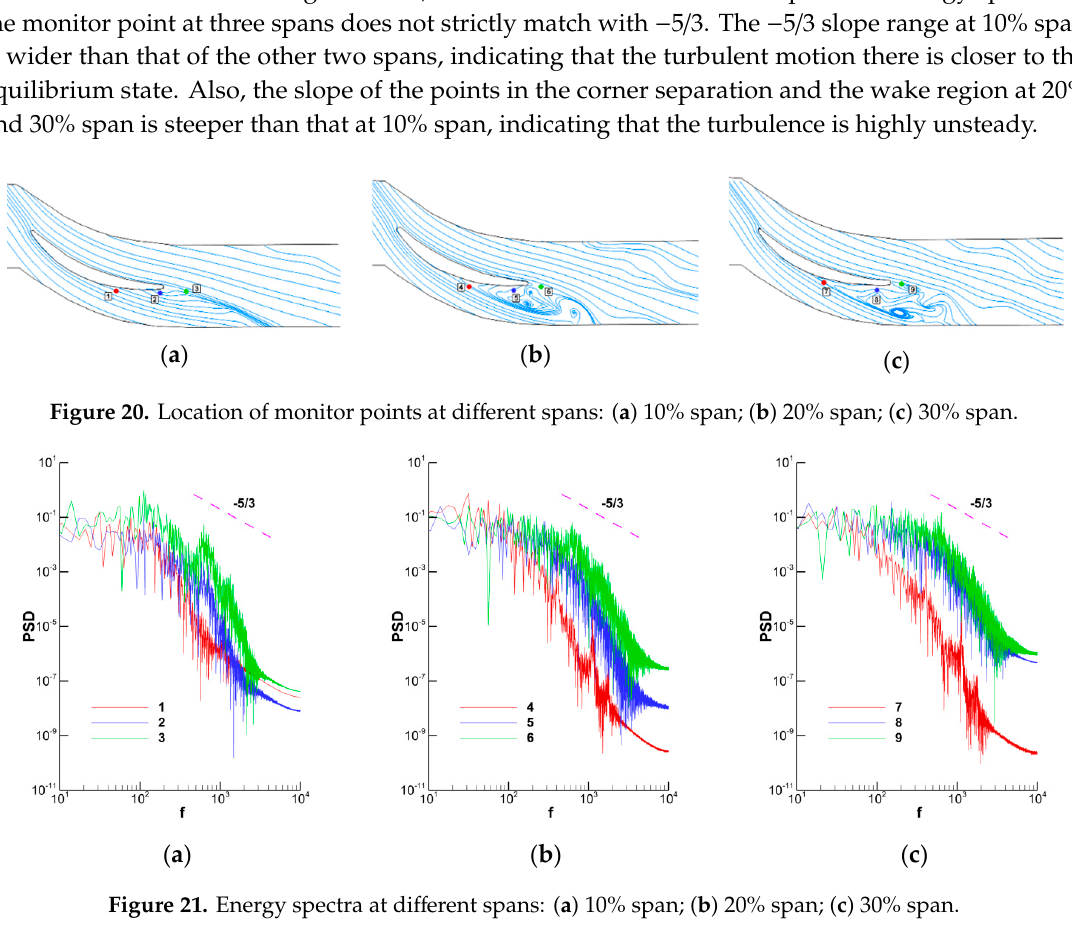
Figure 22. Helicity in the corner separation region: ( a ) contour of helicity density; ( b ) isosurface of helicity density. 7. Discussion In this paper, the flow structures and unsteady behavior of three-dimensional corner separation in a low-speed compressor stator have been simulated by using the DDES-SA method. The velocity probability density distributions in the mainstream and separation region have been analyzed. The turbulence characteristics in the corner region have been studied, corresponding to the unsteadiness of flow separation. The simulation results have been demonstrated by experiments with good consistency, and the conclusions obtained are as follows: